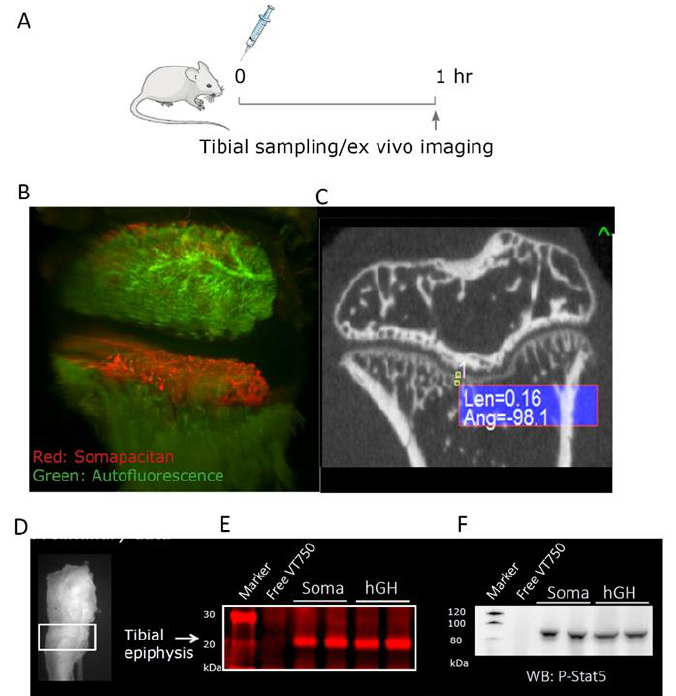
Figure 6. GH analogs can directly activate cells in the proximal epiphyseal tibiae in GH-deficient hypophysectomized rats. ( A ) Illustration of the study design in GH-deficient hypophysectomized rats. Arrow indicate time of ex vivo imaging and termination. ( B ) Ex vivo imaging of tibia from proximal diaphysis to proximal epiphysis of a representative rat 1 h after dosing somapacitan-VT750 in red. Tissue autofluorescence is depicted in green. Bone were scanned with light-sheet fluorescence microscopy, scale bar represents 300 µ m. ( C ) Representative bone scan obtained with micro-computed tomography showing the coronal plane of a hypophysectomized rat calcified bone structures for anatomical reference to LSFM 3D reconstructions. ( D ) Illustration of the dissected part of the proximal tibia. ( E ) Homogenized growth zone of the proximal tibiae lysed and separated on SDS-PAGE, gel scanned at 800 nm to detect NIR labelled GH and somapacitan analogs in homogenates. Samples from two individual rats are depicted along with a control dosed uncoupled VT750. ( F ) Corresponding Western blots showing direct activation of the GHR by both somapacitan and GH represented by P-STAT5 activation in the growth zone of GH-deficient